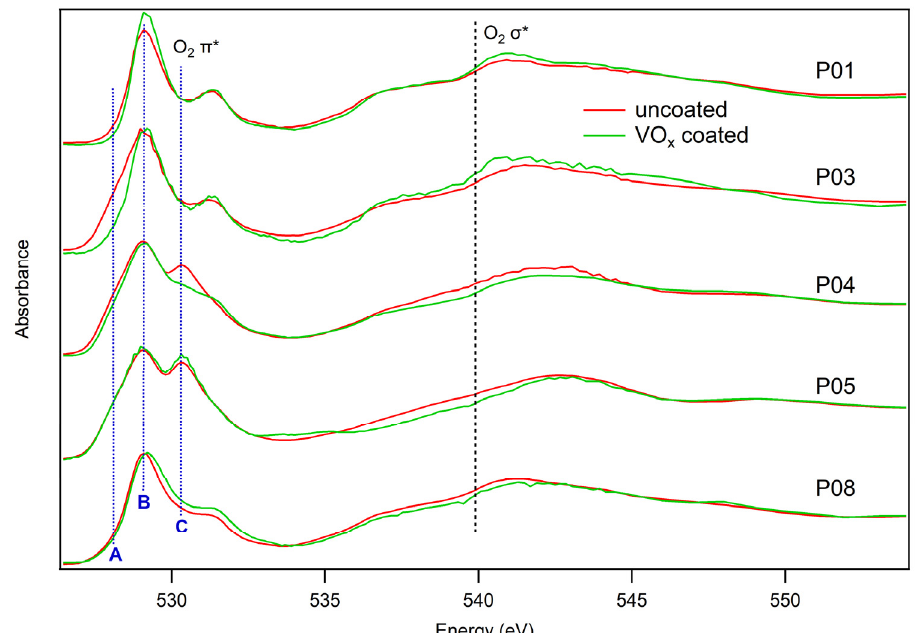
Figure 2. Normalized O-K spectra obtained from the average intensity of valid pixels in the field of view. Coated and noncoated samples of the same point of charge have been grouped to favor comparison. Vertical blue bars mark the position of the three components A , B , C considered in our analysis, while the “O 2 ” labels denote the position of the main features of molecular oxygen according to Ruckman et al. [21]. Note that the O 2 π * feature overlaps with component C.